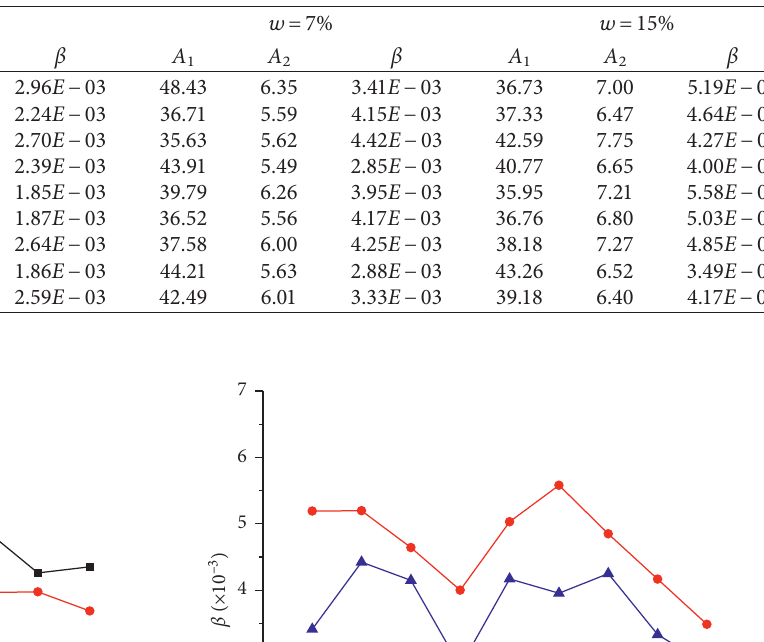
Figure 6: The comparison between predicted data and measured data. Table 7: The measured experimental data and nonlinear coefficient.